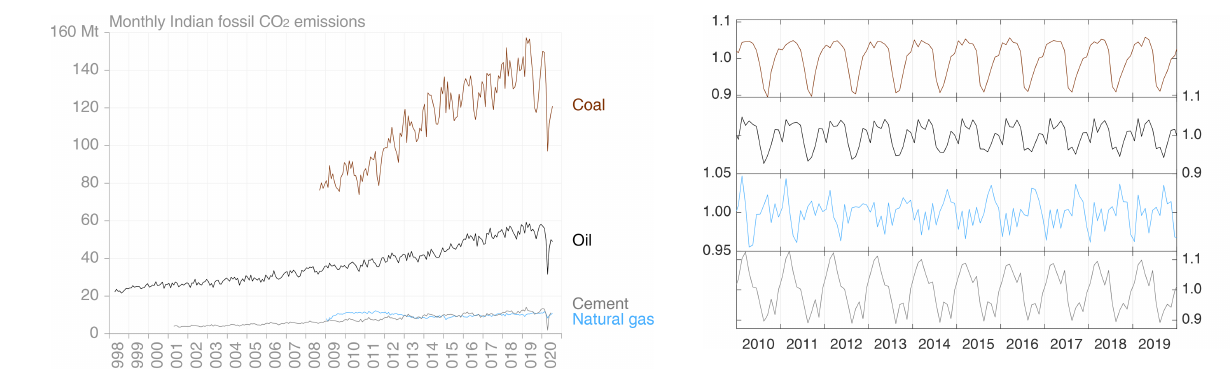
Figure 2. Seasonality of the four emissions categories, derived us- ing the X-11 method. Emissions in 2020 have been excluded from the analysis because of their strong deviations from historical pat-